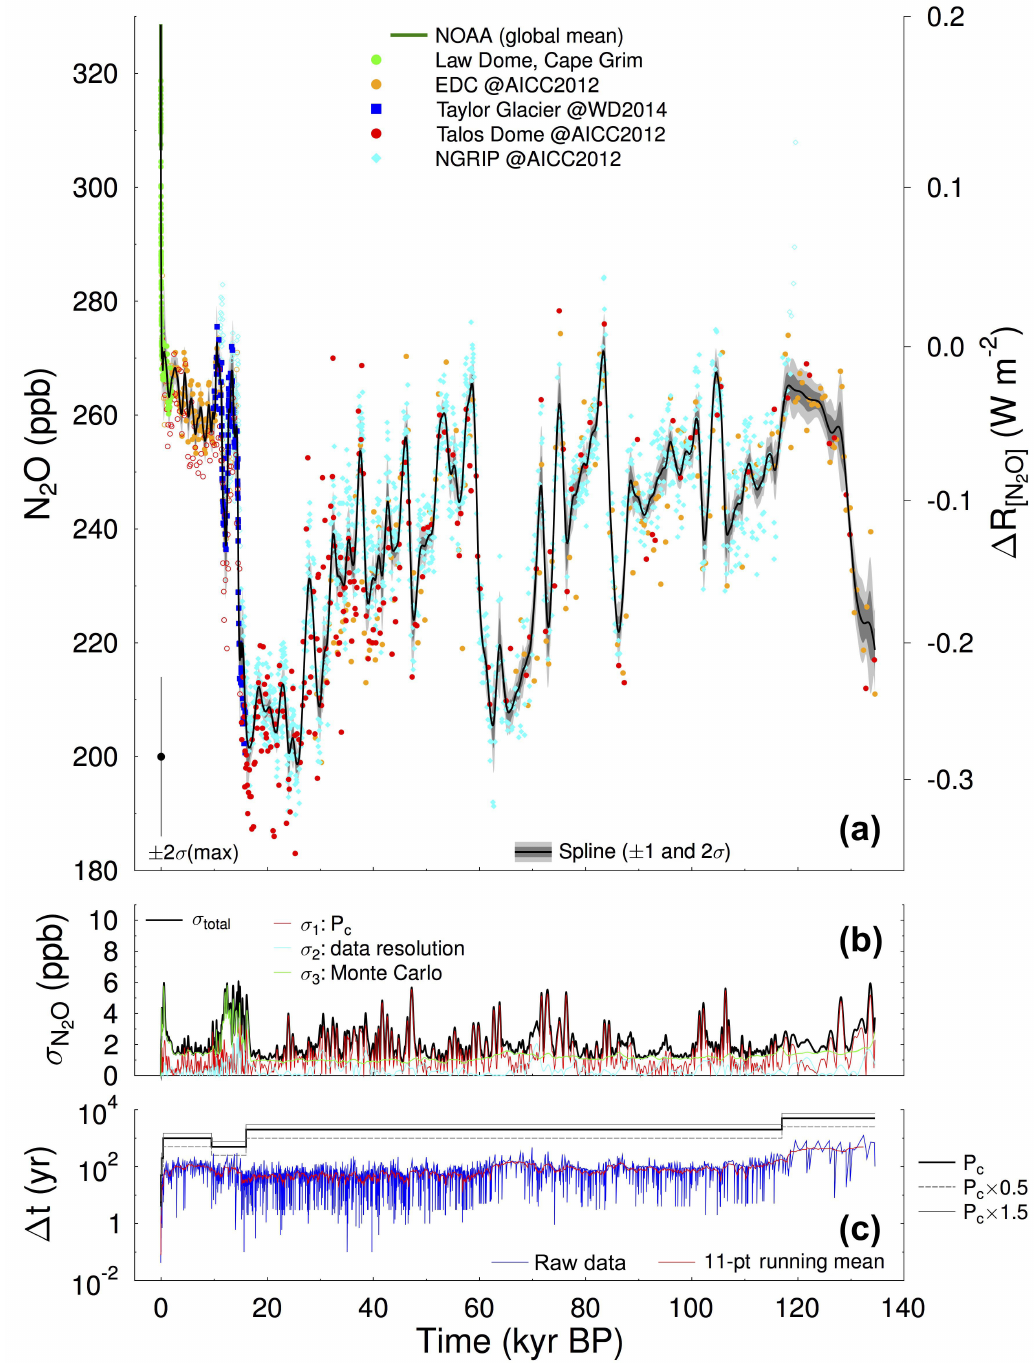
Figure 5. N 2 O spline covering all data: 2016CE–134519BP. Details on plotted data are explained in the text. The maximum ice core data uncertainty ( ± 2 σ ) is sketched in the lower left corner. In (a) the right axis contains the resulting radiative forcing approximated with −√ √ ∼ 0 . 12 · ( (cid:49)R [ N N 2 O / ppb 272)Wm − 2 after Myhre et al. (1998), neglecting interacting effects of CH 4 and N 2 O. Filled symbols: 2 O ] data taken for spline; open symbols: data not taken for spline. (b) Total uncertainty of the spline based on three individual error sources; see text for details. (c) Temporal resolution ( (cid:49)t ) of the N 2 O data points underlying the spline on a log scale. Additionally, the prescribed time-dependent cutoff period P c is plotted, including its variation by ± 50%, which has been used to determine σ 1 .